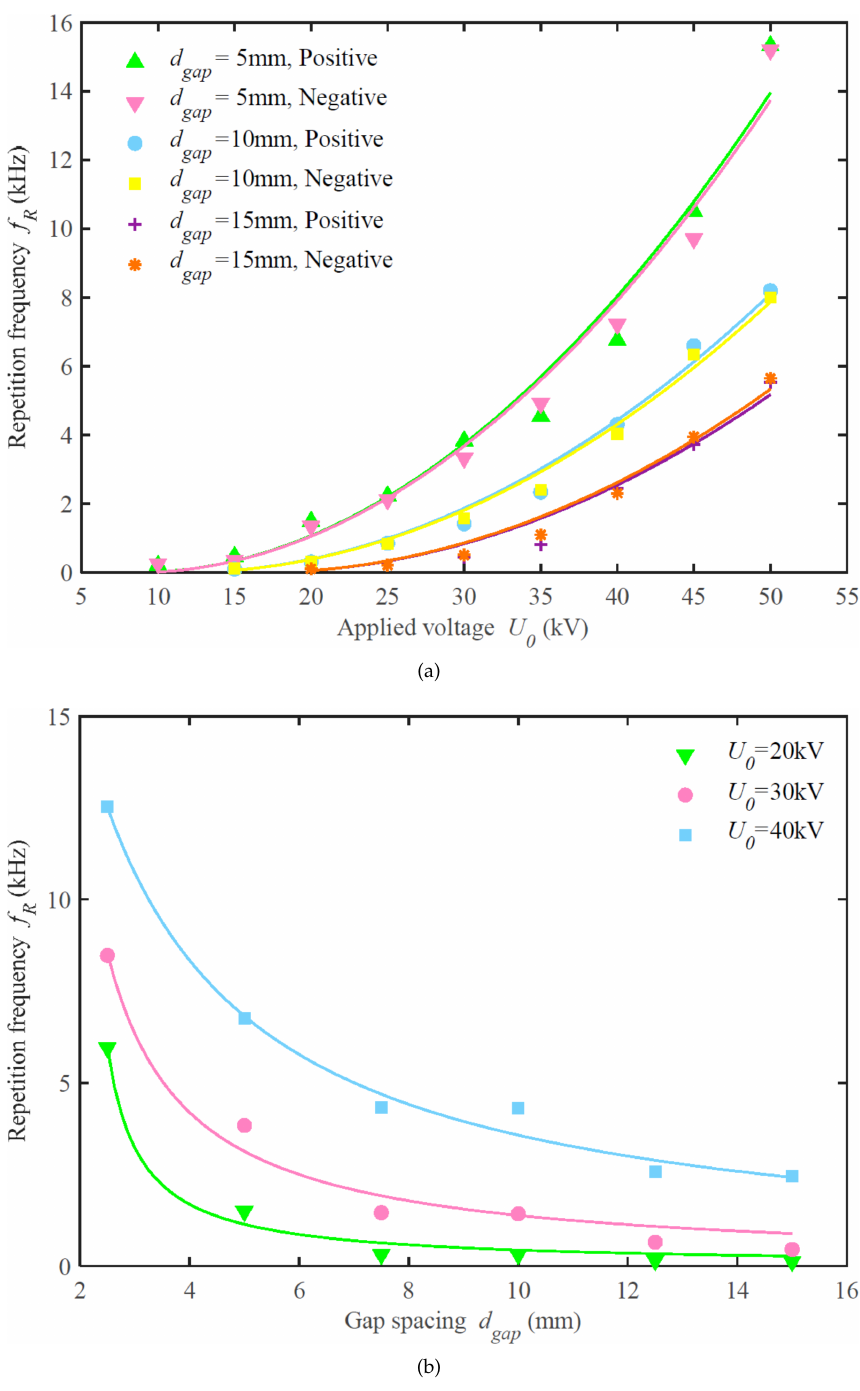
Figure 9. Dependency of the repetition frequency [8] on ( a ) applied voltage, ( b ) inter-electrode gap. Reproduced with permission from [8]; published by MDPI,